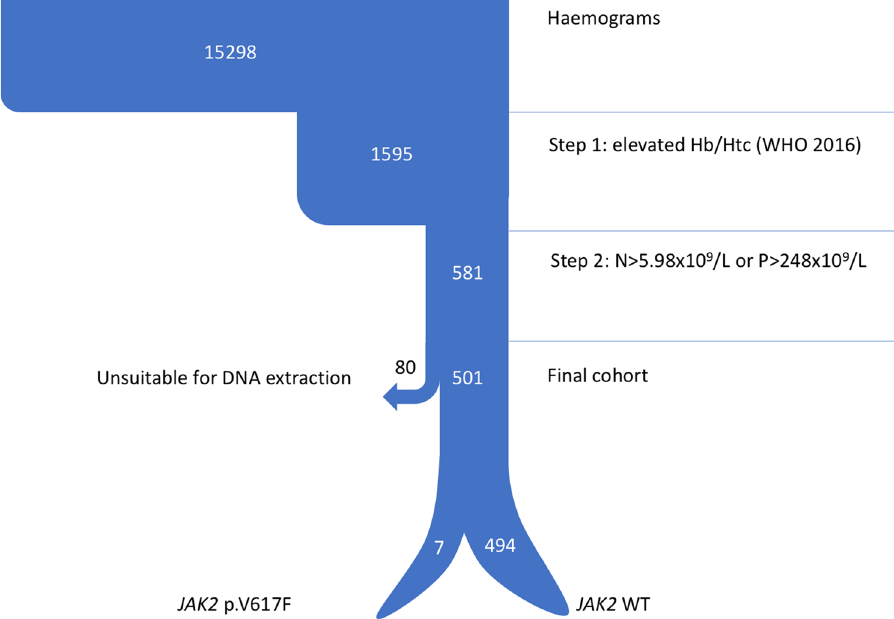
Figure 3. Step 2 sample flowchart. This figure contains a diagram of the samples selected in the different steps of the algorithm. N neutrophils, P platelets, WHO World Health Organization, WT wild